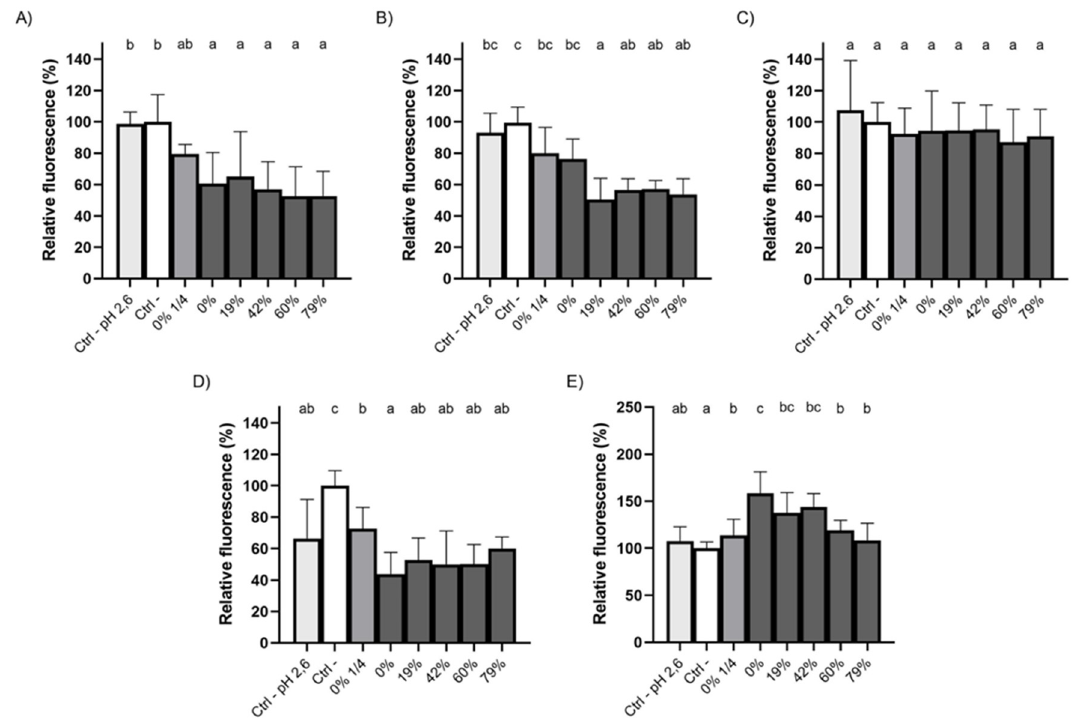
Figure 3. Adherence of FITC-labelled ( A ) S. mutans , ( B ) S. sobrinus , ( C ) S. gordonii , ( D ) S. oralis , and ( E ) S. salivarius to saliva-coated HA preconditioned (5 min) with raw or deacidified (0, 19, 42, 60, and 79%) cranberry juice. A 100% value was attributed to the negative control. Results are expressed as means ± SD of triplicate assays from three independent experiments. Columns with different letters are significantly different from one another (ANOVA, Bonferroni test, p < 0.01). Ctrl: PBS.